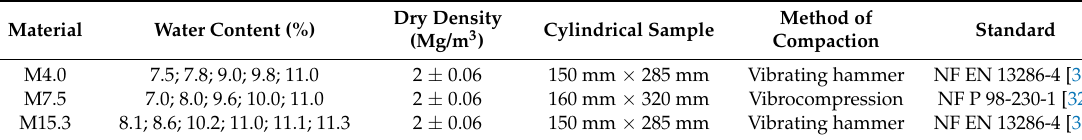
Table 2. Characteristics of the samples.